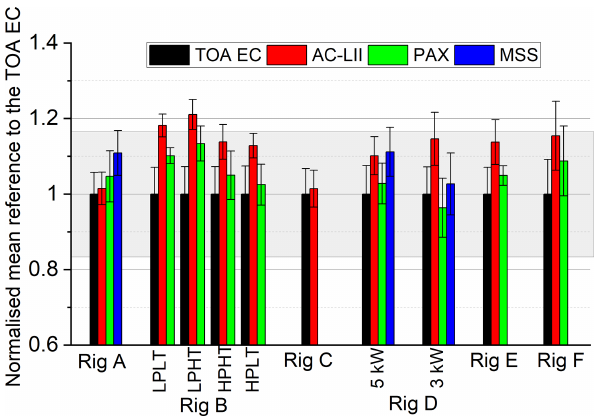
Figure 13. Comparison of the mass concentration results from the multiple rigs and diagnostic techniques. The shaded area marks the 16.7% uncertainty in the TOA from the NIOSH method (NIOSH, 2003). The nvPM mass concentrations are in the range of 90–470µgm − 3 from Rig A, 500–600µgm − 3 from Rig B, 670– 780µgm − 3 from Rig C, 300–550µgm − 3 from Rig D 5kW, 200– 270µgm − 3 from Rig D 3kW, 230–590µgm − 3 from Rig E, and 20–70µgm − 3 from Rig